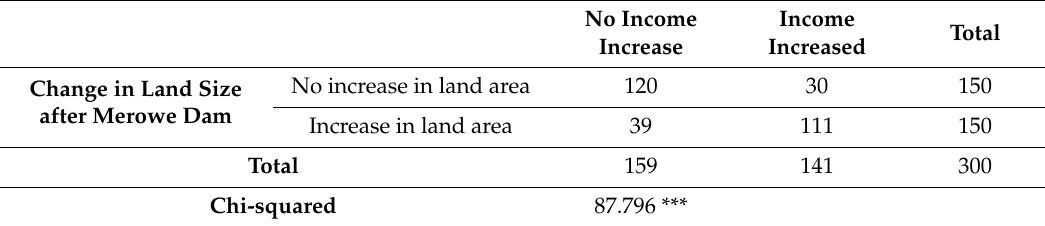
Table 6. Relationship between increase in land area and income due to Merowe